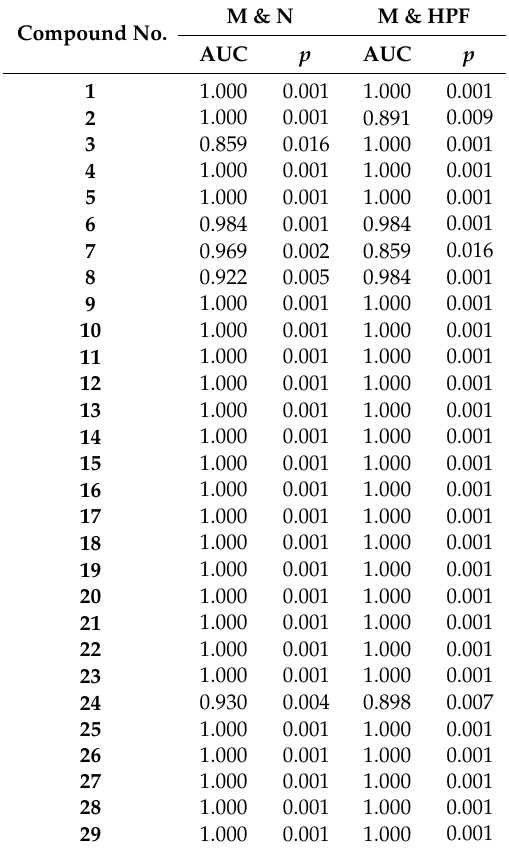
Figure 11. Heatmap of all potential biomarkers. The color indicates the relative abundance of the biomarkers. Green, lowest; red, highest. Rows indicate potential biomarkers, and columns indicate samples. The numbers marked are consistent with the No. of each biomarker in Table 1. Table 2. The AUCs and p values of the biomarkers in di ff erent predictive ROC curves. Compound